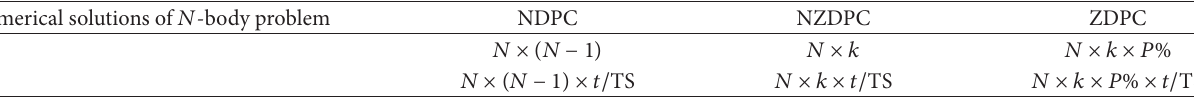
Table 1: Communication traffic comparison of numerical solutions of 𝑁 -body problem. Numerical solutions of 𝑁 -body